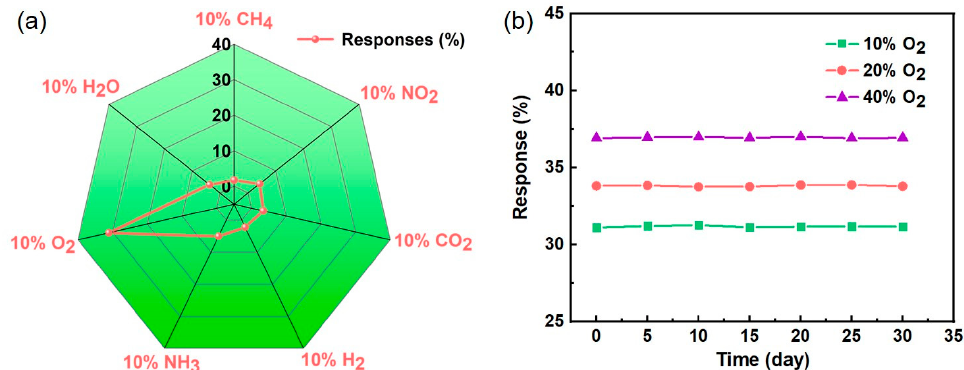
Figure 8. ( a ) Selectivity of Au/ZnO NRs sample upon exposure to different gasses in nitrogen. ( b ) Long-term stability of Au/ZnO NRs sensor upon exposure to 10%, 20%, and 40% oxygen in nitrogen gas.